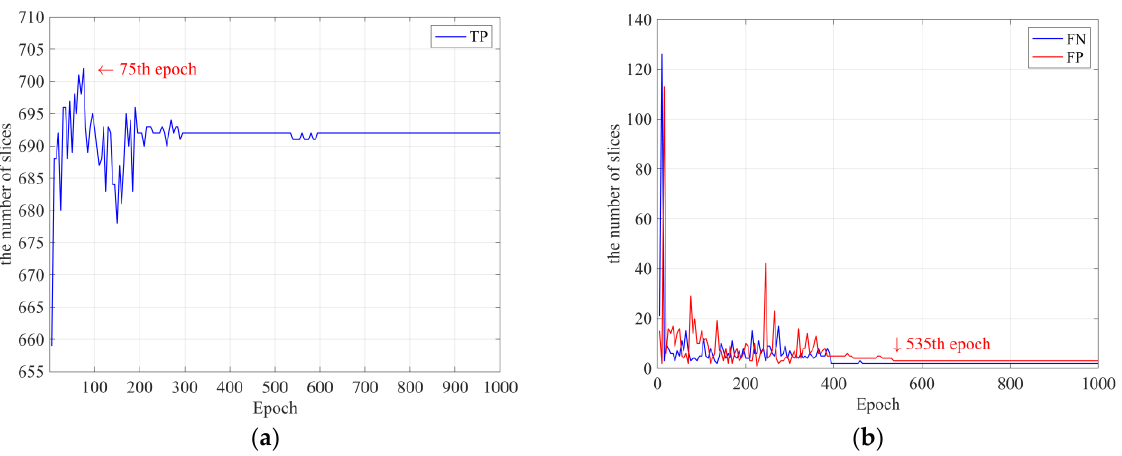
Figure 7. Training result of detection models and classification models created in each epoch: ( a ) the number of true-positive slice groups in detection models; ( b ) the number of false-positive and false-negative slice groups in classification models.